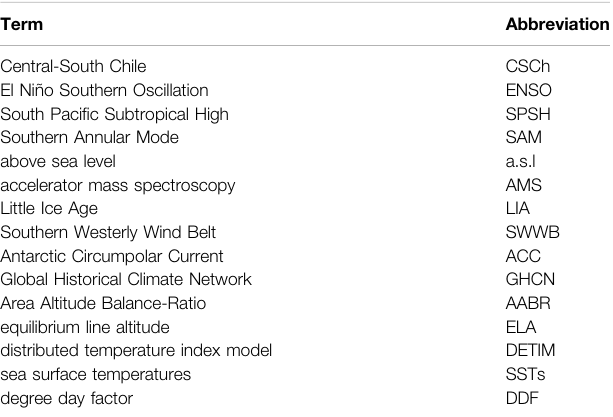
TABLE 1 | Abbreviations used in